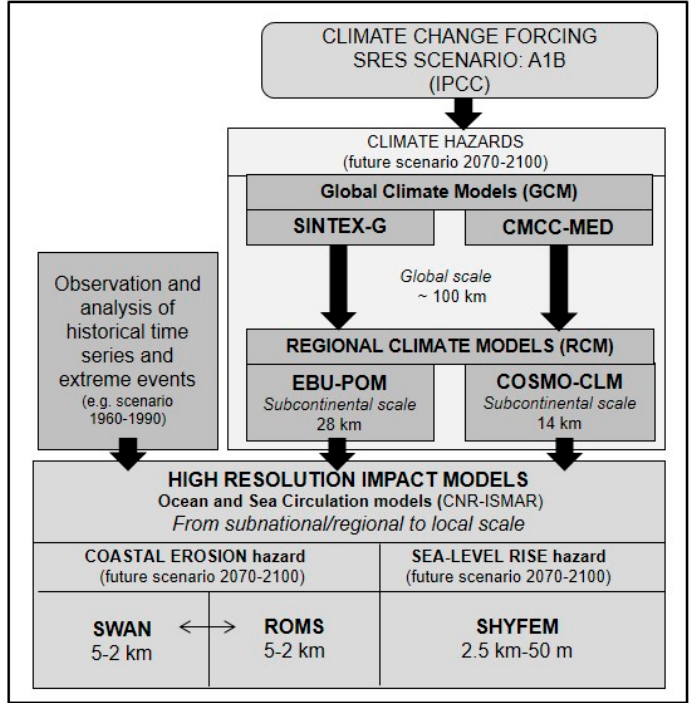
Figure 2. The multi-model chain applied to define climate change hazard scenarios in the North Adriatic coastal area. Names in brackets refer to partners who applied each model.